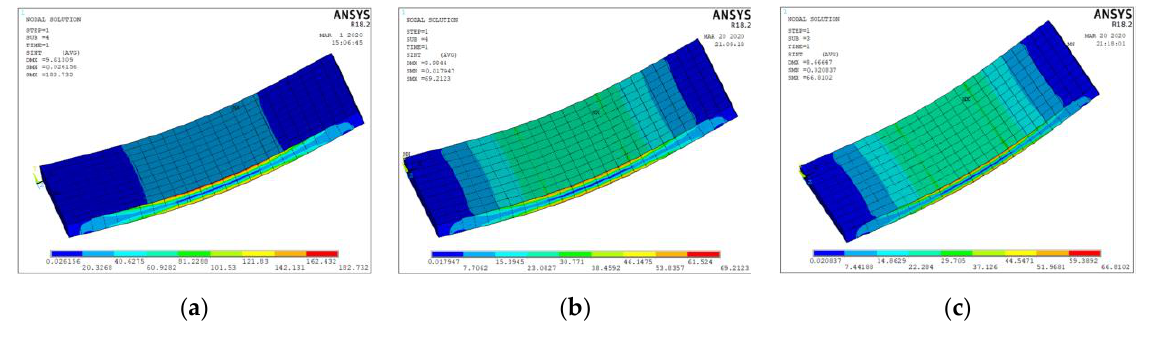
Figure 18. Stress nephogram of composite floor with different steel thickness: ( a ) 1.0, ( b ) 1.5 and ( c ) 2.0 mm.